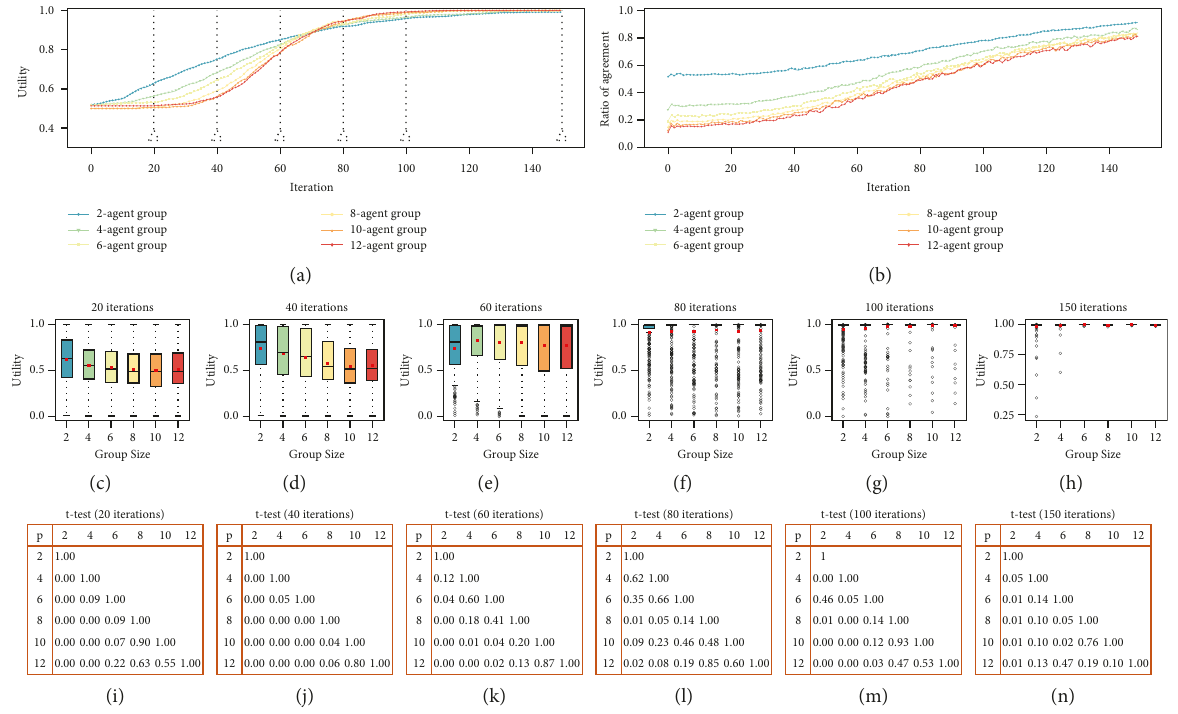
Figure 5: Change of utility of group solution (500 independent Monte Carlo experiments) and the ratio of agreement (500 independent Monte Carlo experiments) over iteration (discussion time) on 1-peak problem space. (a) Group performance over discussion time for groups of sizes 2, 4, 6, 8, 10, and 12. (b) Ratio of agreement over discussion time for groups of sizes 2, 4, 6, 8, 10, and 12. Note. Each curve shows the average result of 500 independent Monte Carlo experiments. (c) Utility of group solution after 20 iterations. (d) Utility of group solution after 40 iterations. (e) Utility of group solution after 60 iterations. (f) Utility of group solution after 80 iterations. (g) Utility of group solution after 100 iterations. (h) Utility of group solution after 150 iterations. Those boxplots in (c), (d), (e), (f), (g), and (h) represent the 25 th and 75 th percentiles of the group solution’s utility of distinct group sizes across 500 independent Monte Carlo experiments. The black horizontal line and the red dot in each box indicate the median value and mean value, respectively. (i) t -test results of the utility of group solution among groups of distinct sizes after 20 iterations. (j) t -test results of the utility of group solution among groups of distinct sizes after 40 iterations. (k) t -test results of the utility of group solution among groups of distinct sizes after 60 iterations. (l) t -test results of the utility of group solution among groups of distinct sizes after 80 iterations. (m) t -test results of the utility of group solution among groups of distinct sizes after 100 iterations. (n) t -test results of the utility of group solution among groups of distinct sizes after 150